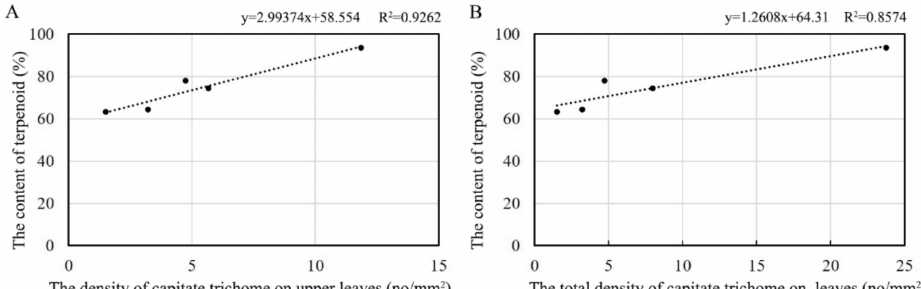
Figure 9. Regression analysis of the leaf terpenoid contents and the density of trichomes on ( A ) the upper leaf surface and ( B ) the whole leaf